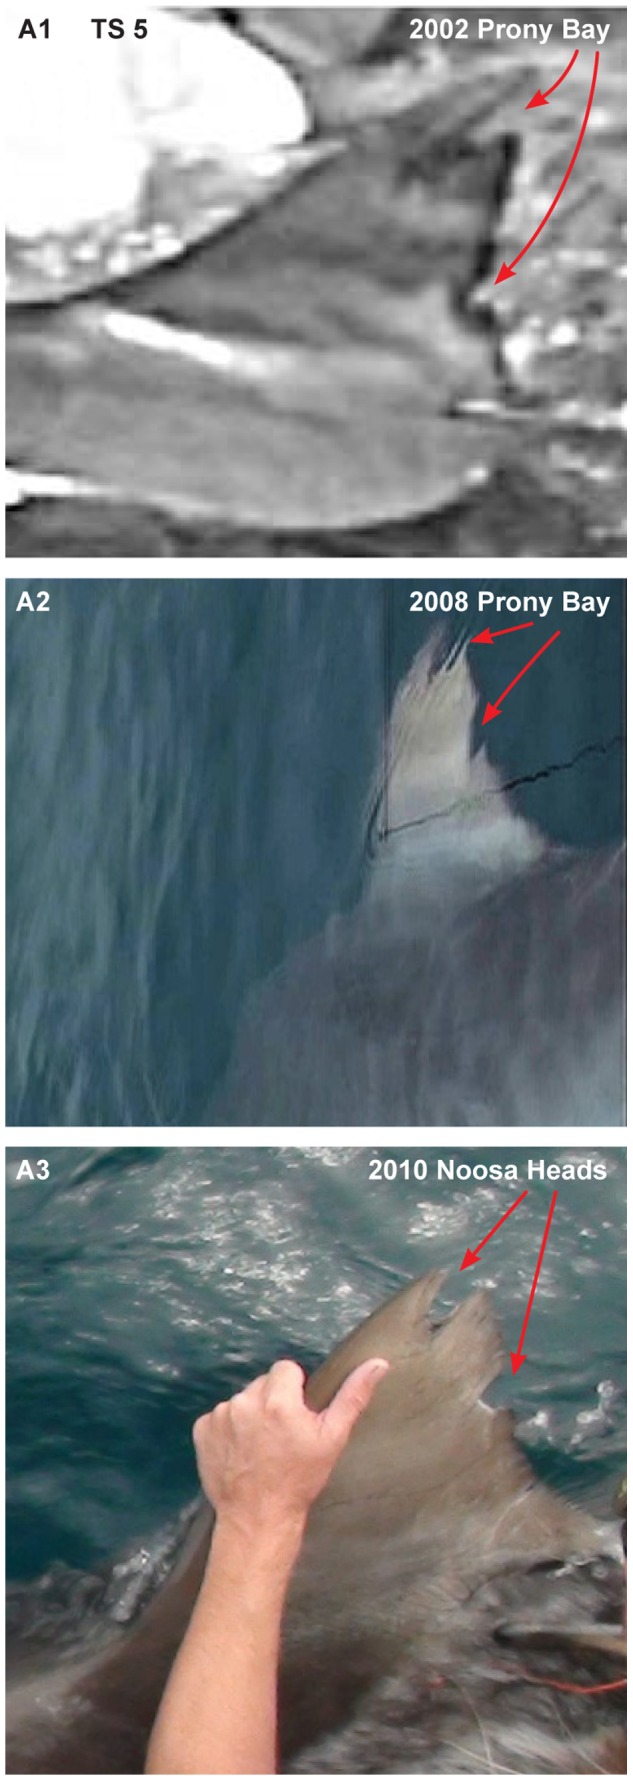
Resightings of individual tiger shark based on dorsal fins.Arrows highlight the distinguishing features of the individual sharks fin. Note A1 was identified by Clua et al. [55]. The photo taken in A3 is after a tissue sample was taken from the second notch in the shark’s dorsal fin.